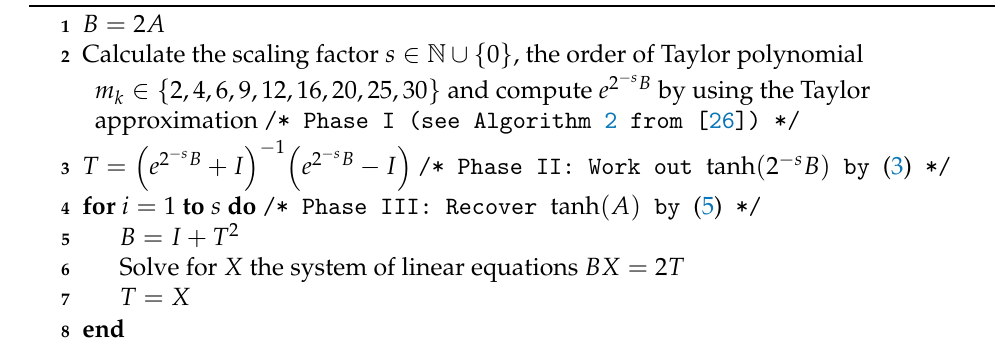
Algorithm 1: Given a matrix A ∈ C n × n , this algorithm computes T = tanh ( A )